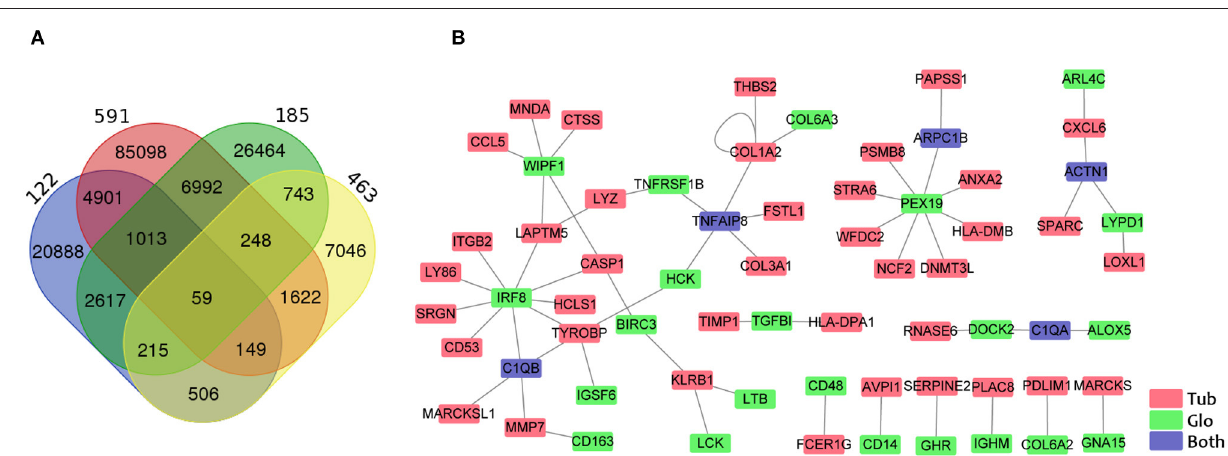
FIGURE 4 | Identification of genes correlated between the tubule and the glomerulus. (A) Venn diagram shows the overlapping of associated gene pairs in four datasets. (B) Visualization of 59 paired genes correlated in the tubules and glomeruli in all four datasets. Red, green, and blue colors indicate the GECs in the tubules, glomeruli, and both the tubules and the glomeruli. methodology pipeline of the identification of interaction genes in the tubules and